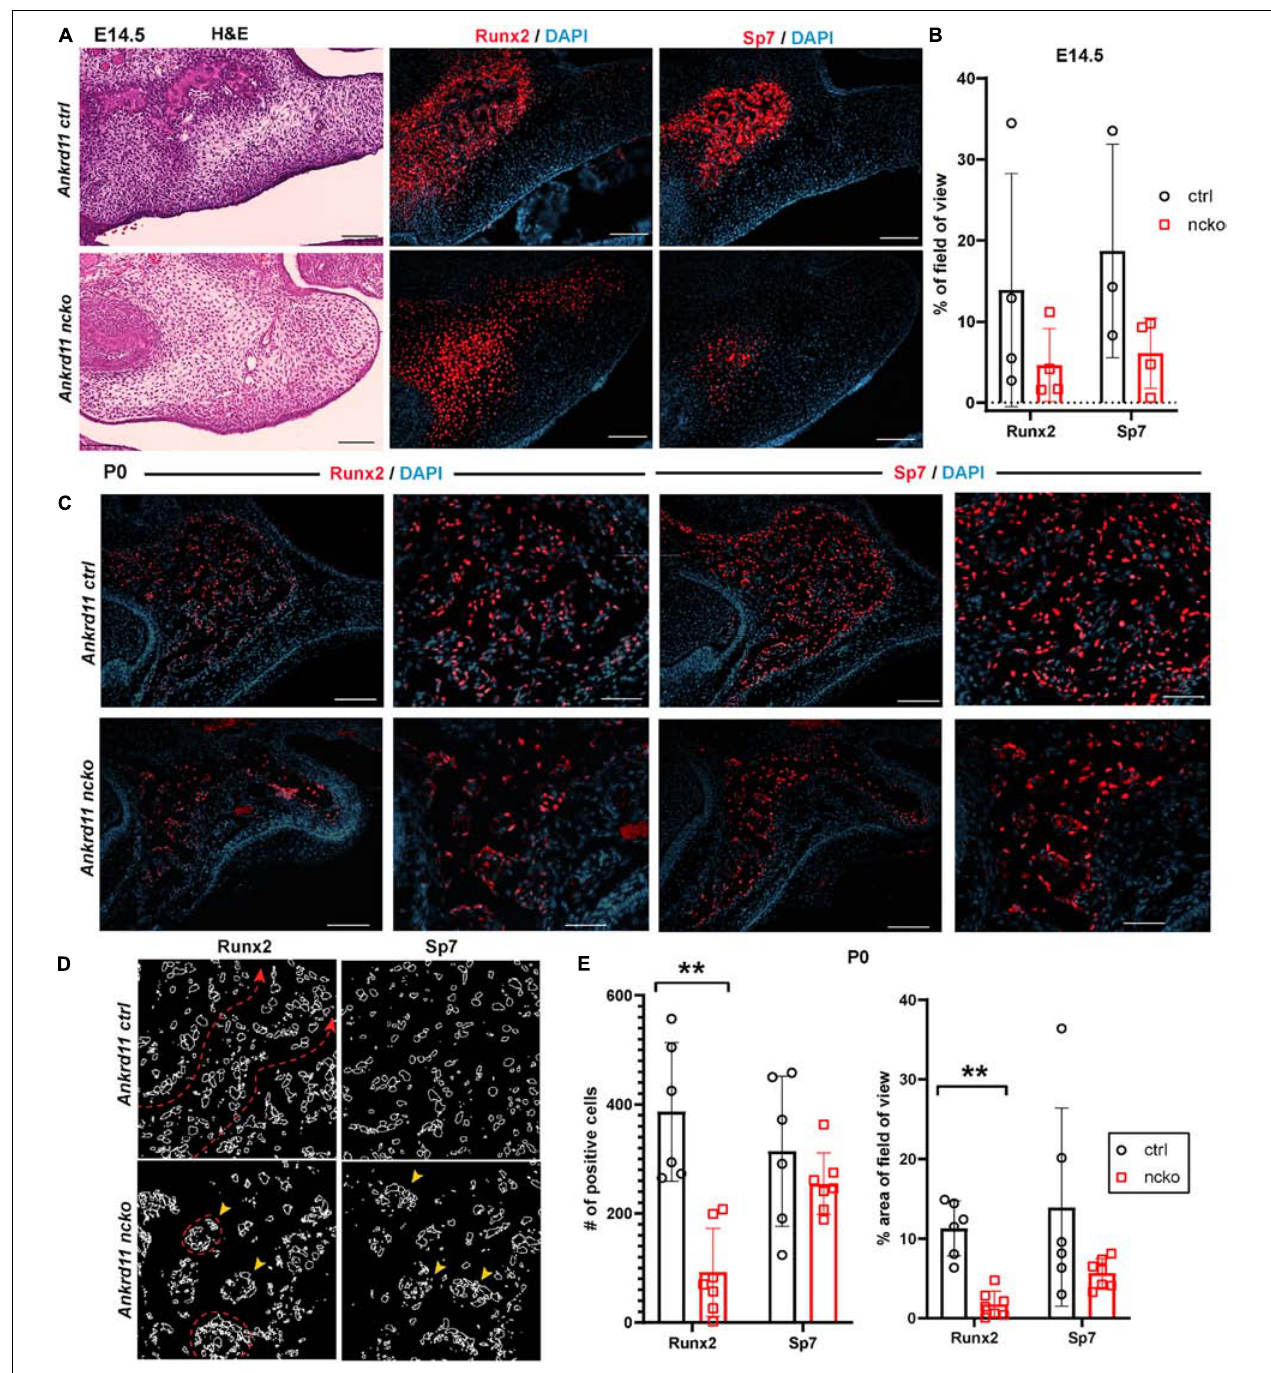
FIGURE 6 | Bone formation in Ankrd11 ncko mice is dysregulated in late embryonic development. (A) Palatal region in E14.5 Ankrd11 ctrl (upper row) and Ankrd11 ncko (lower row) embryos H&E stained for orientation (left column) and immunostained for runt-related transcription factor 2 (Runx2) and Osterix (Sp7) (middle and right columns). Scale bars indicate 100 µ m. (B) Quantification of % occupancy of field of view stained for Runx2 and Sp7 (independent two-sample T -test assuming unequal variances). (C) Low and high magnification images of palatal bone in P0 Ankrd11 ctrl (upper row) and Ankrd11 ncko (lower row) pups immunostained for Runx2 (left two columns) and Sp7 (right two columns). DAPI (blue) was used to counterstain nuclei. (D) Representation of individual cells expressing Runx2 and Sp7 generated using ImageJ showing altered cell distribution in the mutant. Red dotted line and arrowhead indicates extended trabeculae in control, whereas red circles and yellow arrowheads indicate more contained cellular clusters in the mutant. Scale bars in first and third columns represent 100 µ m, and second and fourth represent 50 µ m. (E) Quantification of Runx2 and Sp7 expression at P0 (left: number of positive cells; right: percent area per field of view) showing significant reduction of the area of Runx2 expression, whereas Sp7 expression domain was more contained but not statistically different at P0 ( n = minimum of six sections form 3–5 pups/genotype, independent two-sample T -test assuming unequal variances, ** p < 0.001).